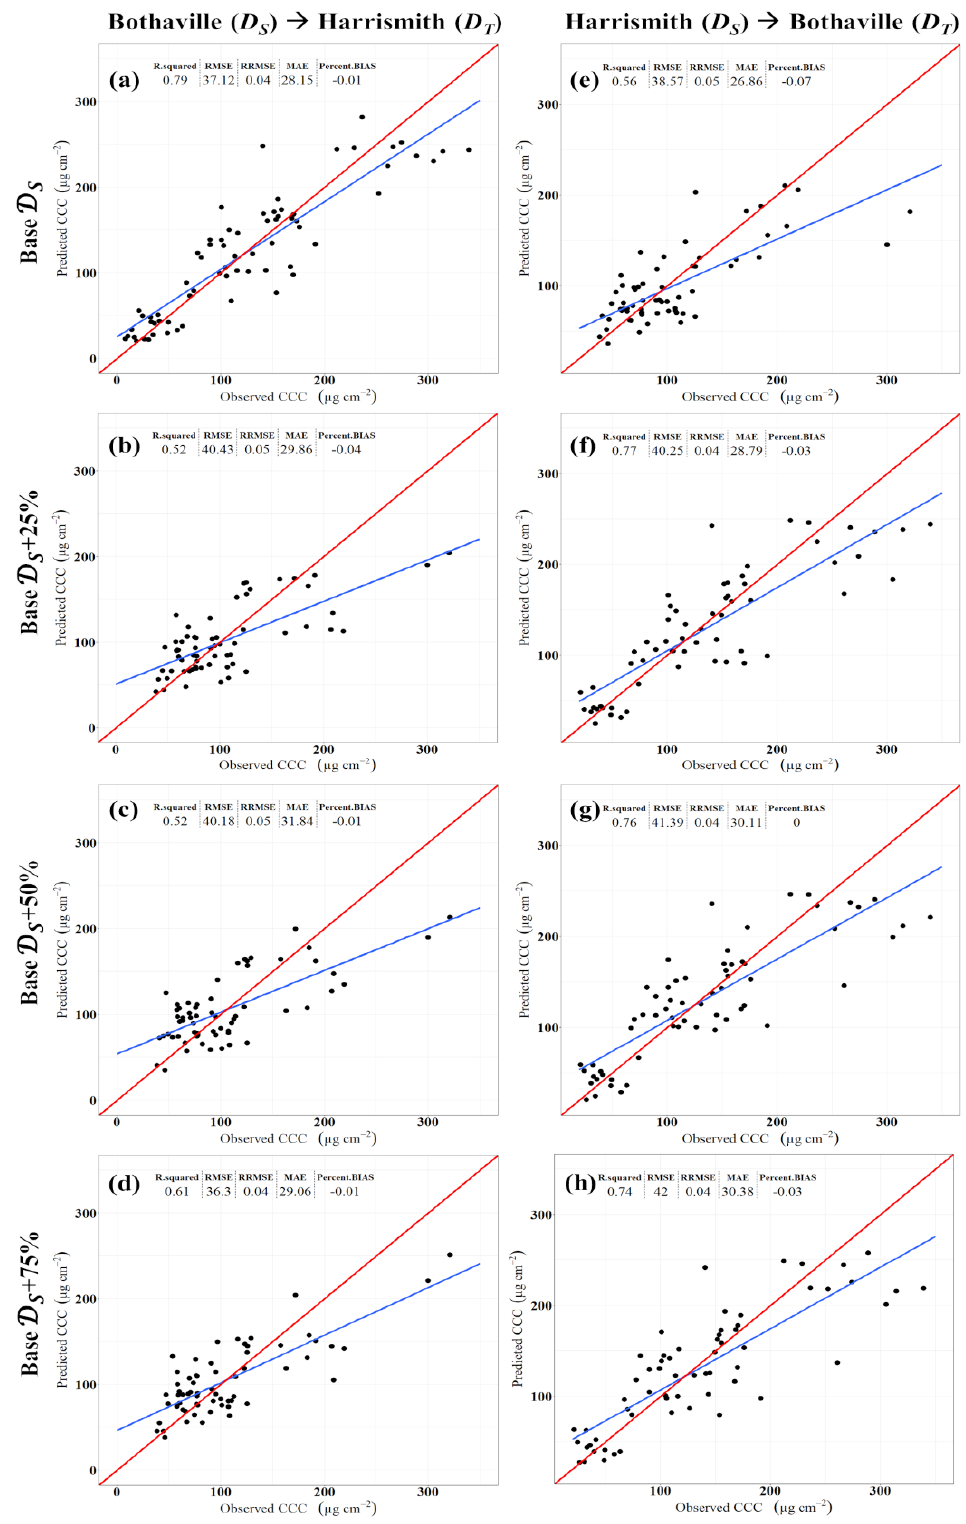
Figure 5. Scatterplots for Canopy Chlorophyll Content (CCC, µg cm − 2 ) indicating the performance of the XGBoost models in the Source D S and Target D T sites considering scenarios where only 25% (Base D S + 25%, ( b , f )), 50% (Base D S + 50%, ( c , g )), and 75% (Base D S + 75%, ( d , h )) of the training data are available in the Target D T site. Base D S models for cases where Bothaville and Harrismith are the Source sites D S are shown in panels ( a , e ), respectively. The 1:1 and the regression lines between the observed and predicted values are shown in red and blue, respectively.